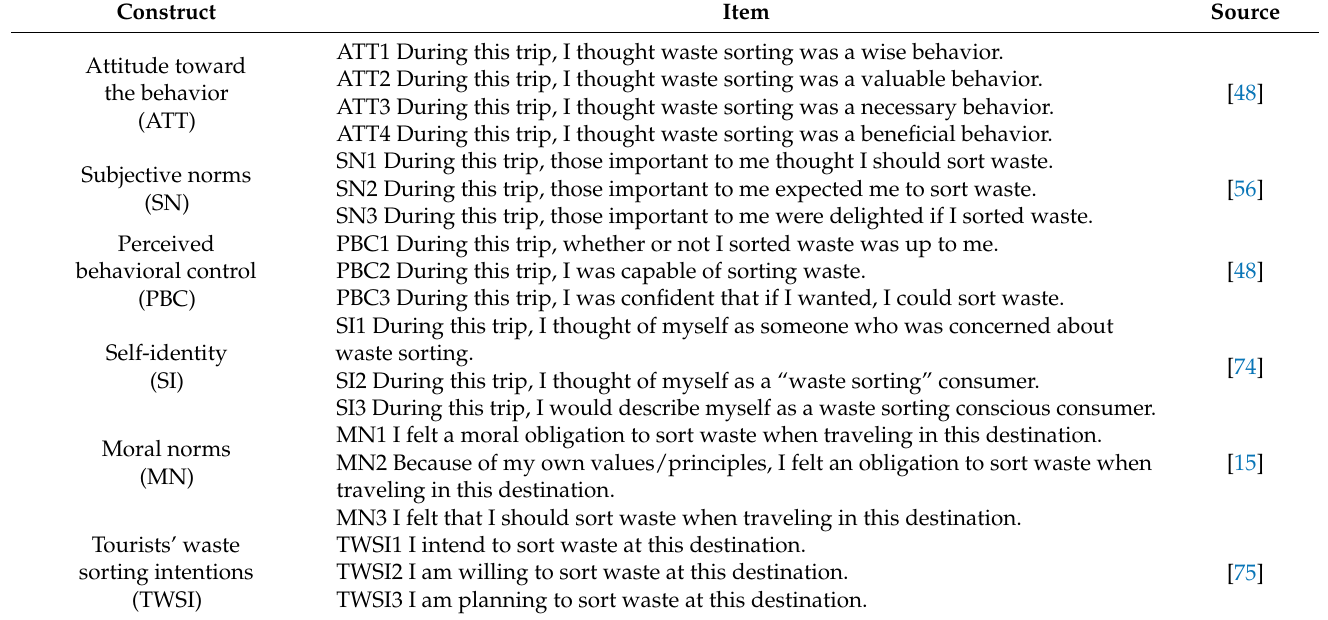
Table A1. Detailed measurements of all variables and literature